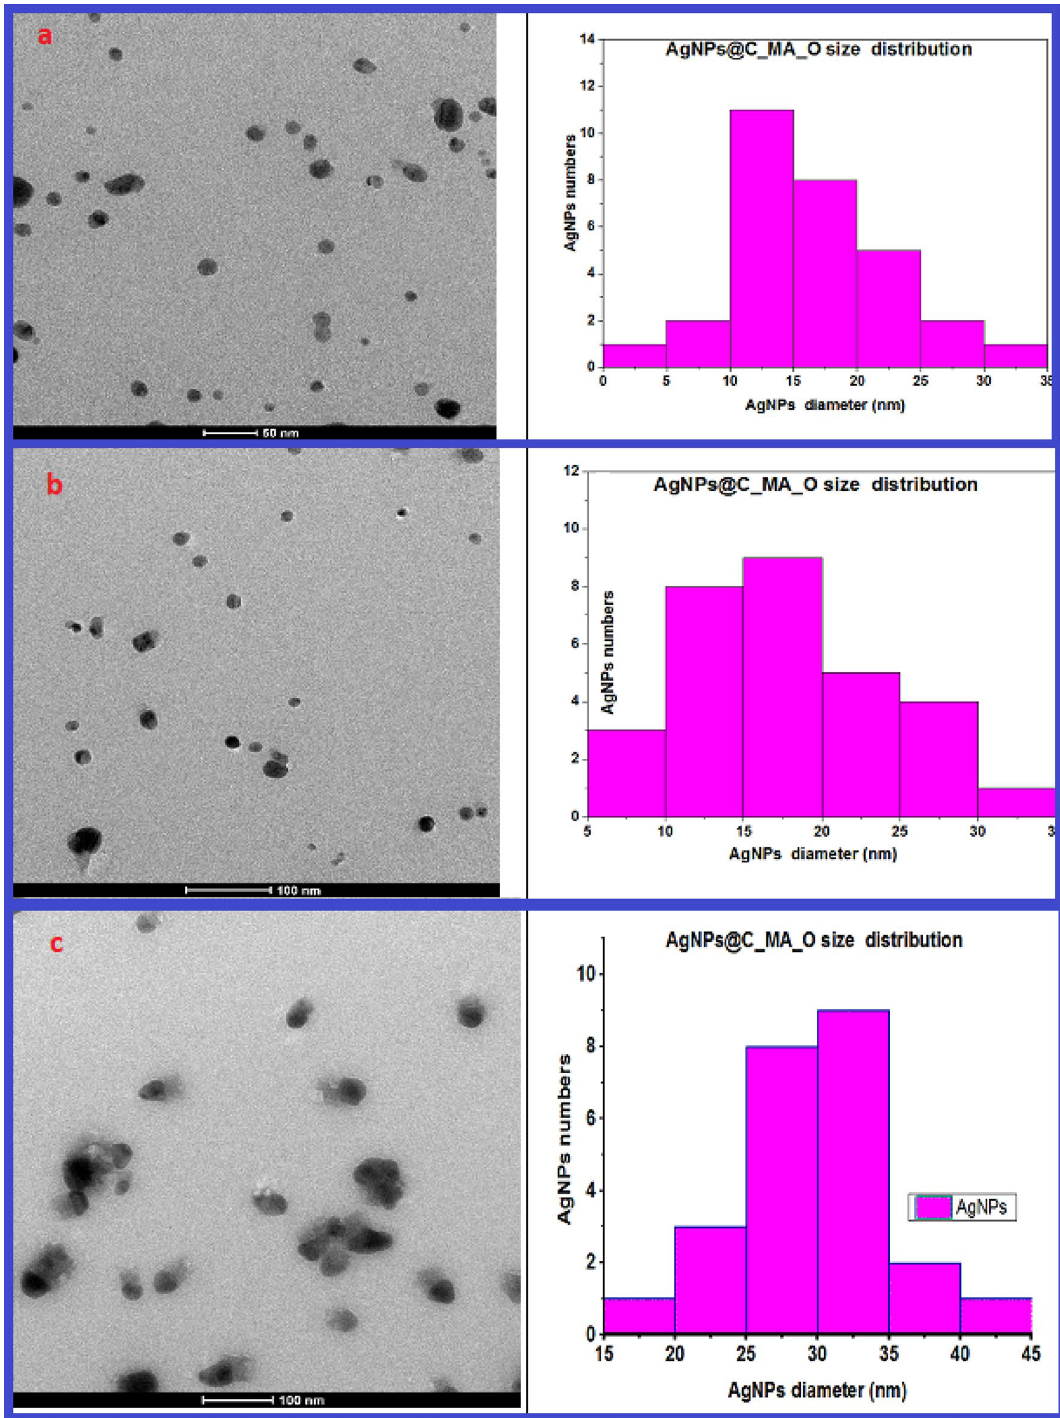
Figure 5. TEM images obtained for a suspended solution of AgNPs@C_MA_O represented in the left side at (a) at 50 nm and (b,c) at 100 nm magnification, respectively. The images (a,b) reveal that diameter AgNPs in range of (16 ± 6)nm and ( 18 ± 6) nm respectively. For stored over 6 months sample (c) average size of AgNPs was obtained approximately in range ( 27 ± 6)